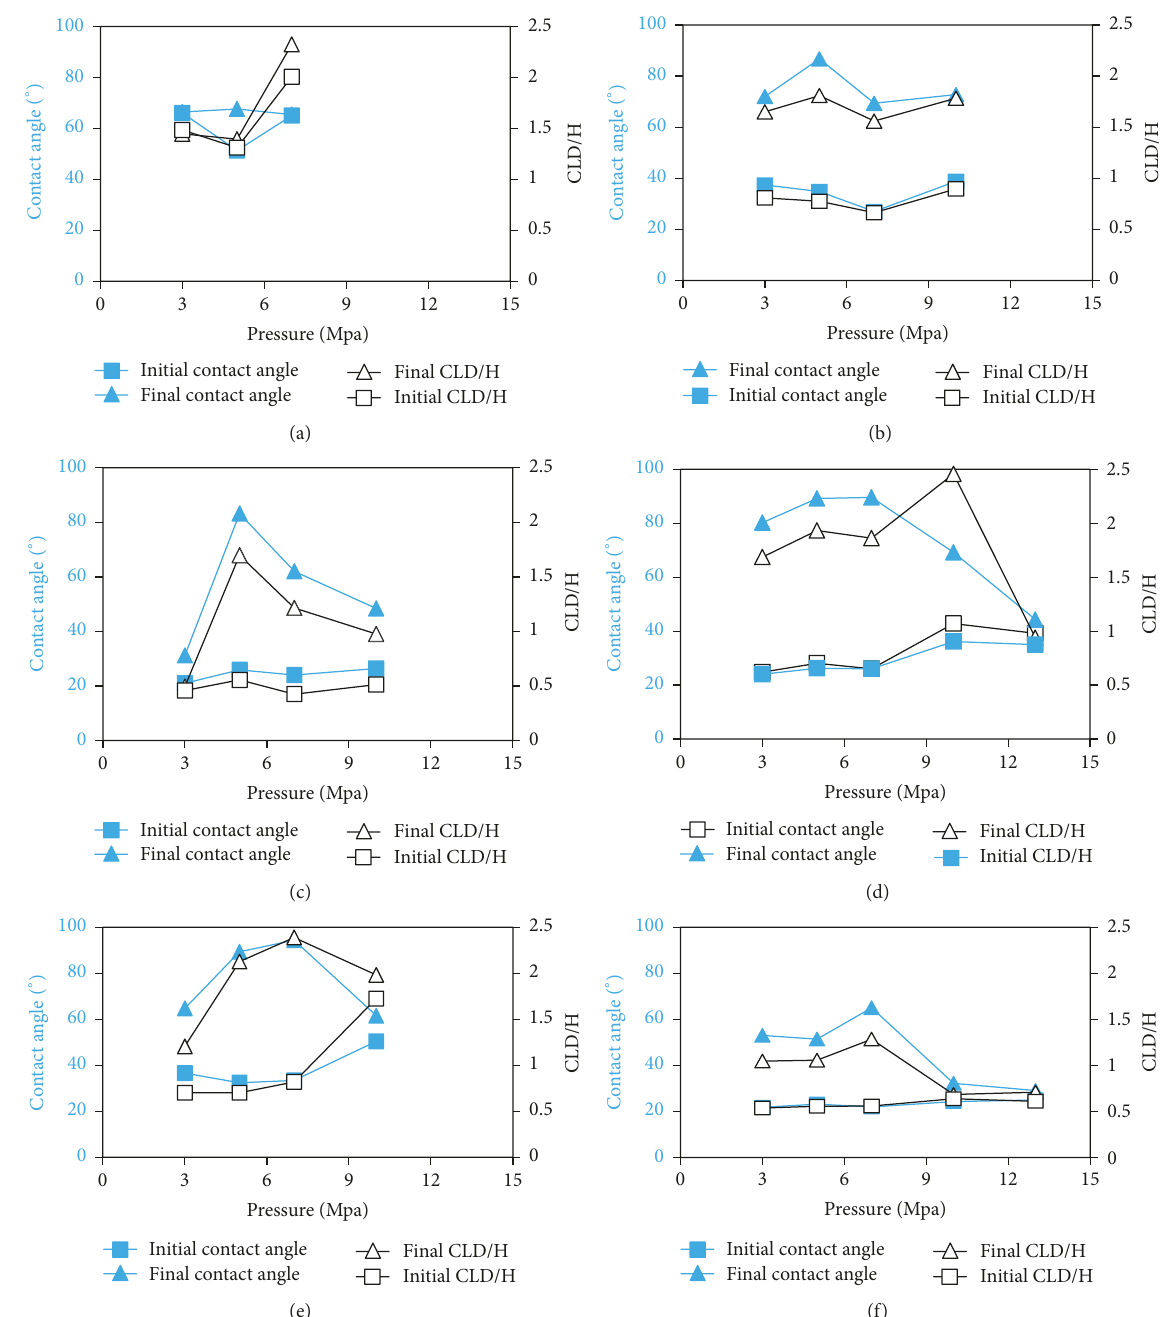
Figure 5: Variations in contact angle and dimensionless number (CLD/H) at various pressures. (a) Type V5 with deionized water, (b) type V1 with deionized water, (c) type V5 with 1MNaCl, (d) type V1 with 1MNaCl, (e) type V5 with 3 MNaCl, and (f) type V1 with 3